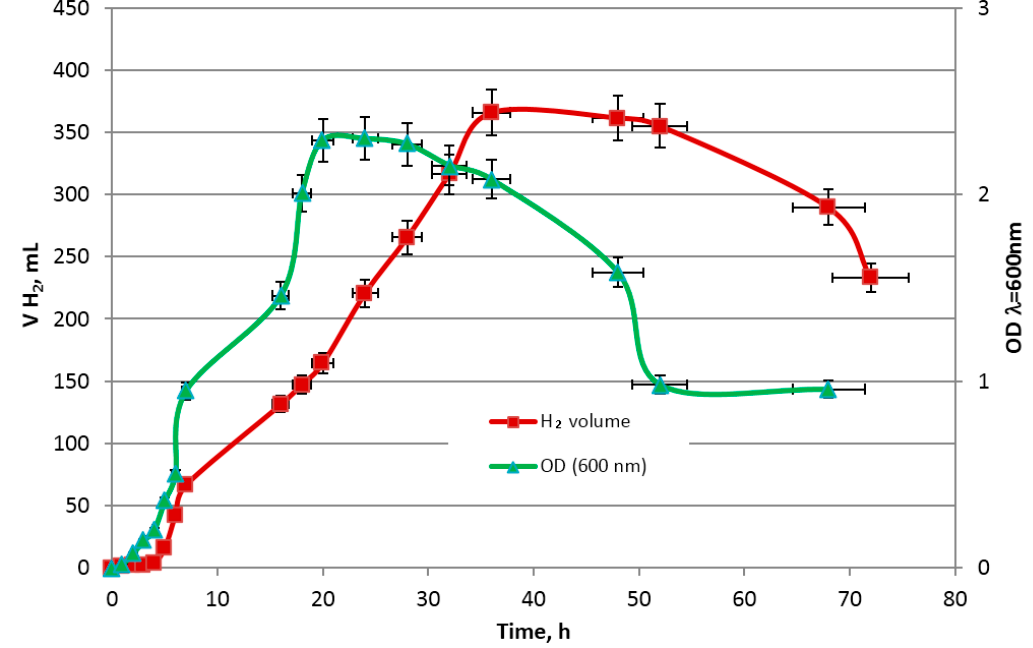
Figure 8. Changes in the volume of obtained hydrogen corresponding to changes OD λ =600 values during dark fermentation.